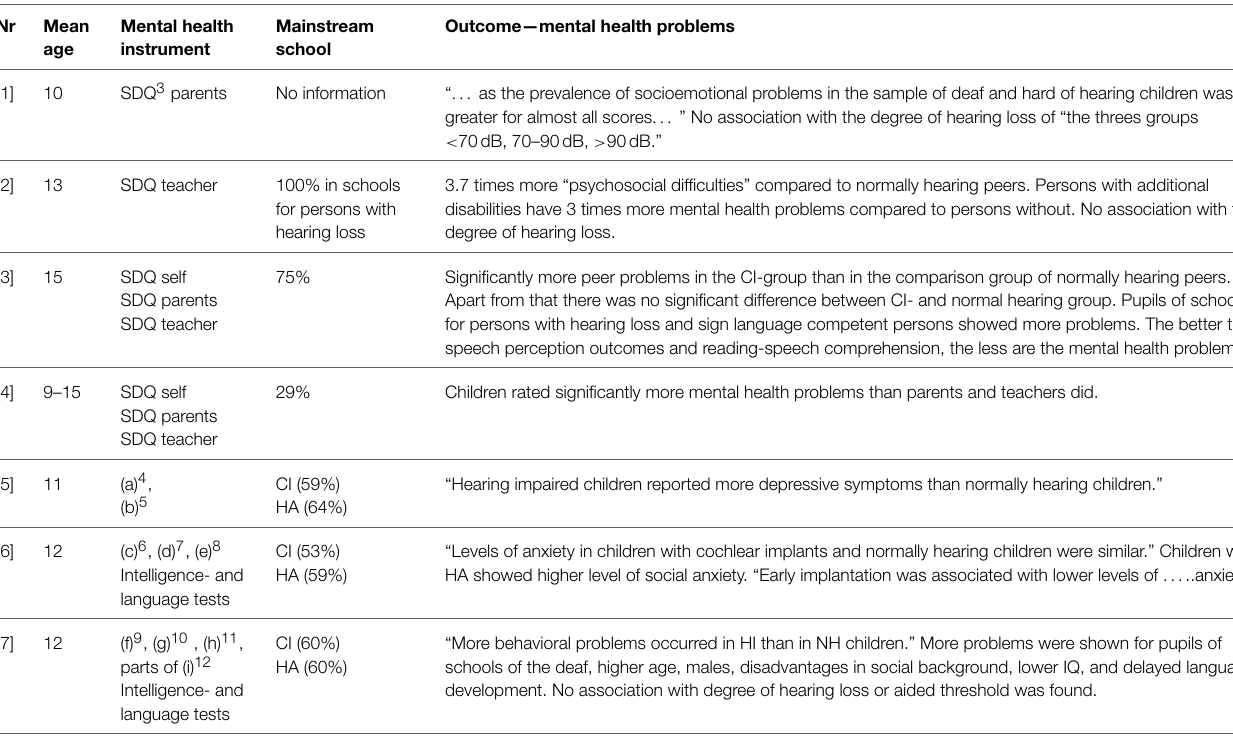
TABLE 1 | Studies on mental health problems of children older than six years and adolescents with cochlear implants (at least 20% of the study